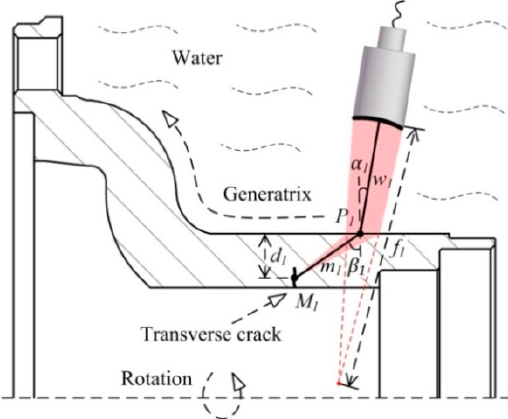
Figure 2. Transverse crack testing of a wheel hub.